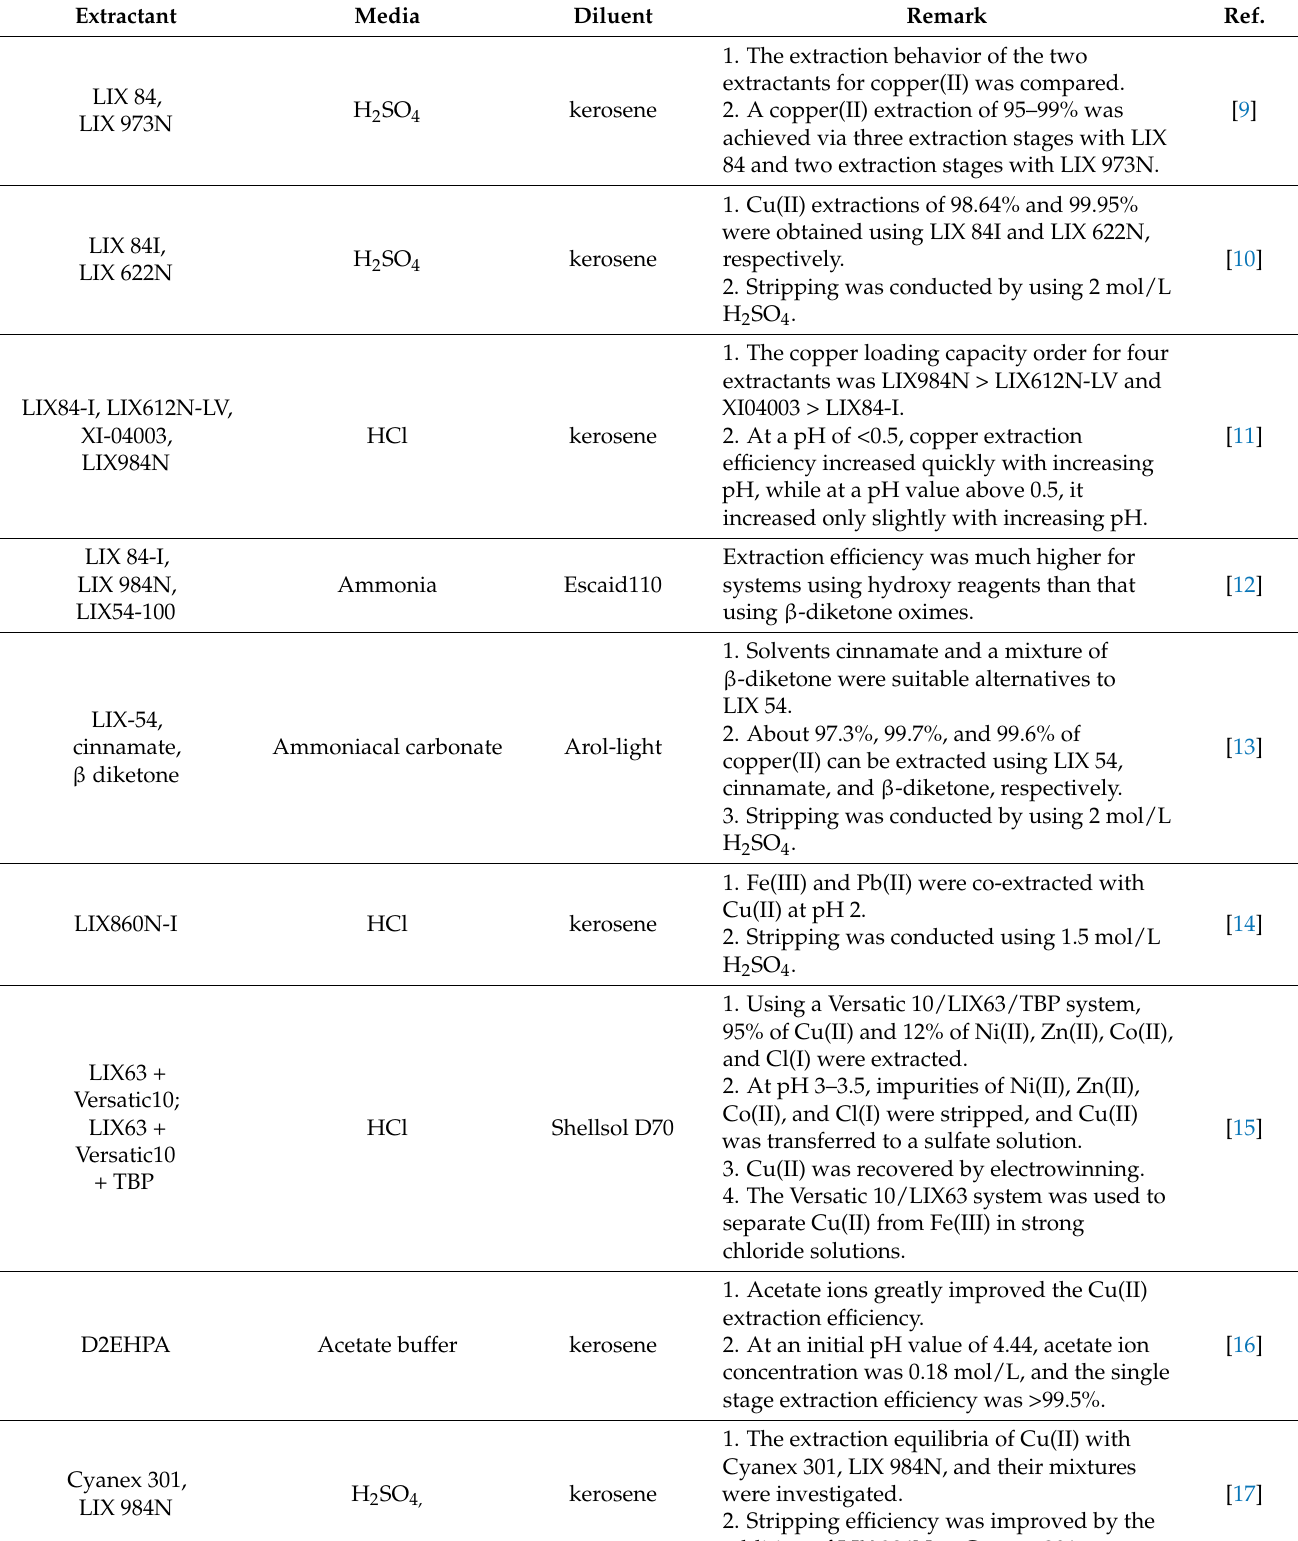
Table 1. Summary of some studies on the extraction of Cu(II) using various extractants.